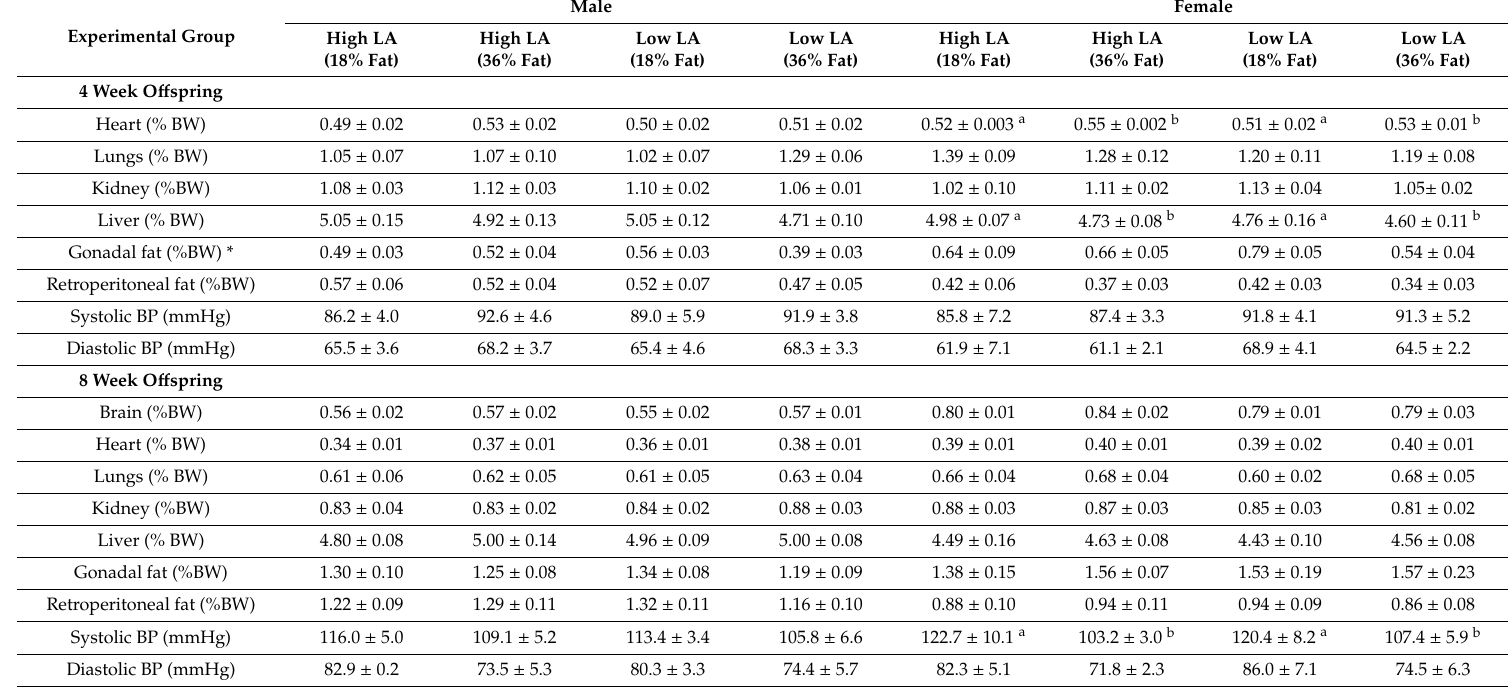
Table 1. O ff spring body composition and blood pressure at 4 and 8 weeks of